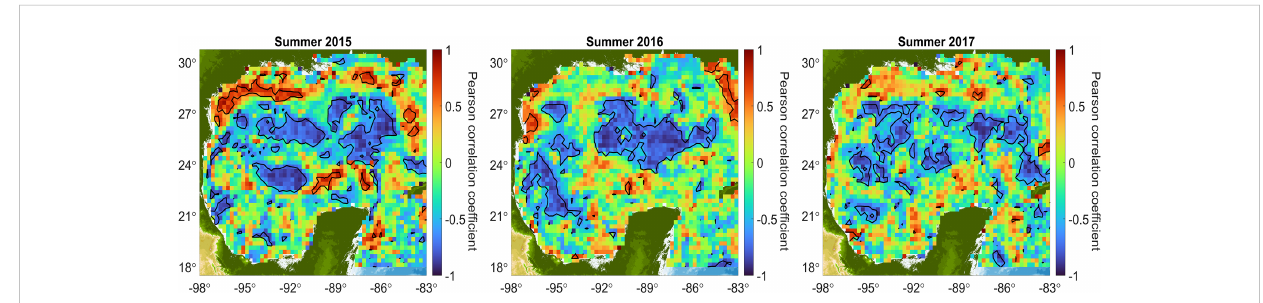
FIGURE 9 Spatial correlation maps for the summers of 2015, 2016, and 2017 between surface POC and SSH ns , both derived from satellite data. Pearson ’ s correlation coef fi cients are shown in colors, with hot colors indicating positive correlation and cold colors negative correlation. The black contours represent a con fi dence level of